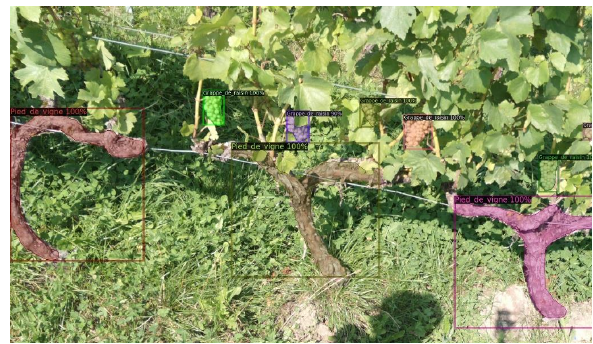
Figure 7: Stocks extraction on one individual image. One can notice that tests have also been conducted on the extraction of grape bunches.